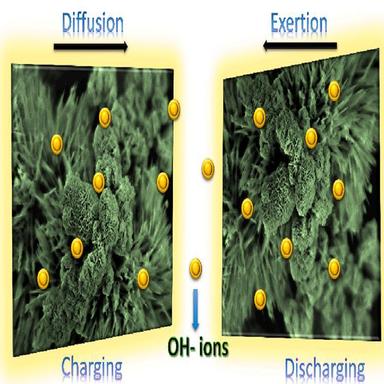
Visual illustration of how diffusion and exertion occur in the synthesized Ni-Co/CoMn2O4 composite material.